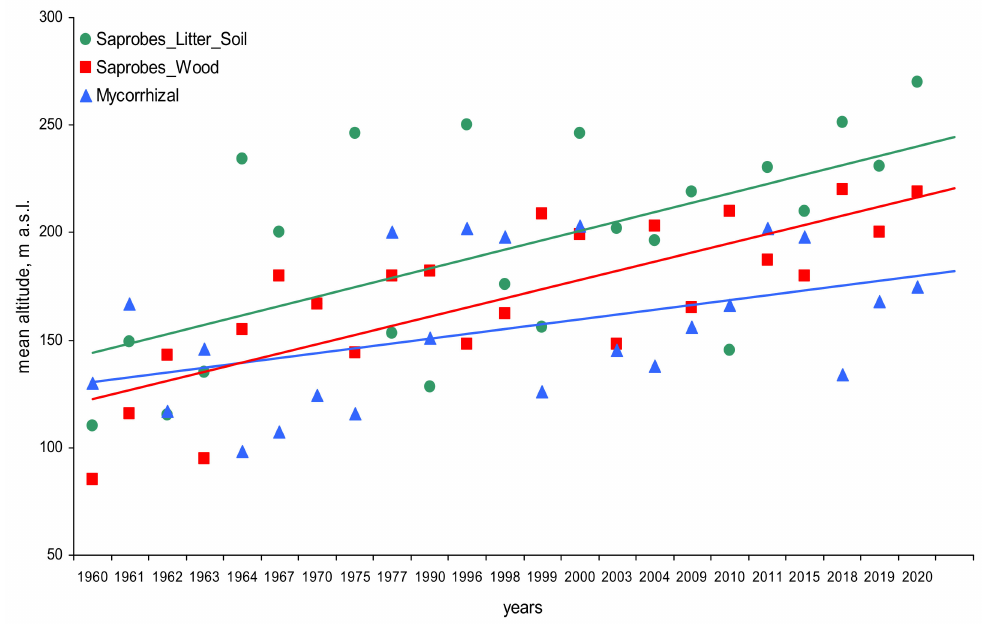
Figure 2. Trends in the mean altitude of fungal fruiting over time for saprobes on litter and soil (green circles; r = 0.51, p = 0.49), saprobes on wood (red squares; r = 0.50, p = 0.47), and ectomycorrhizal species (blue triangles; r = 0.23, p =